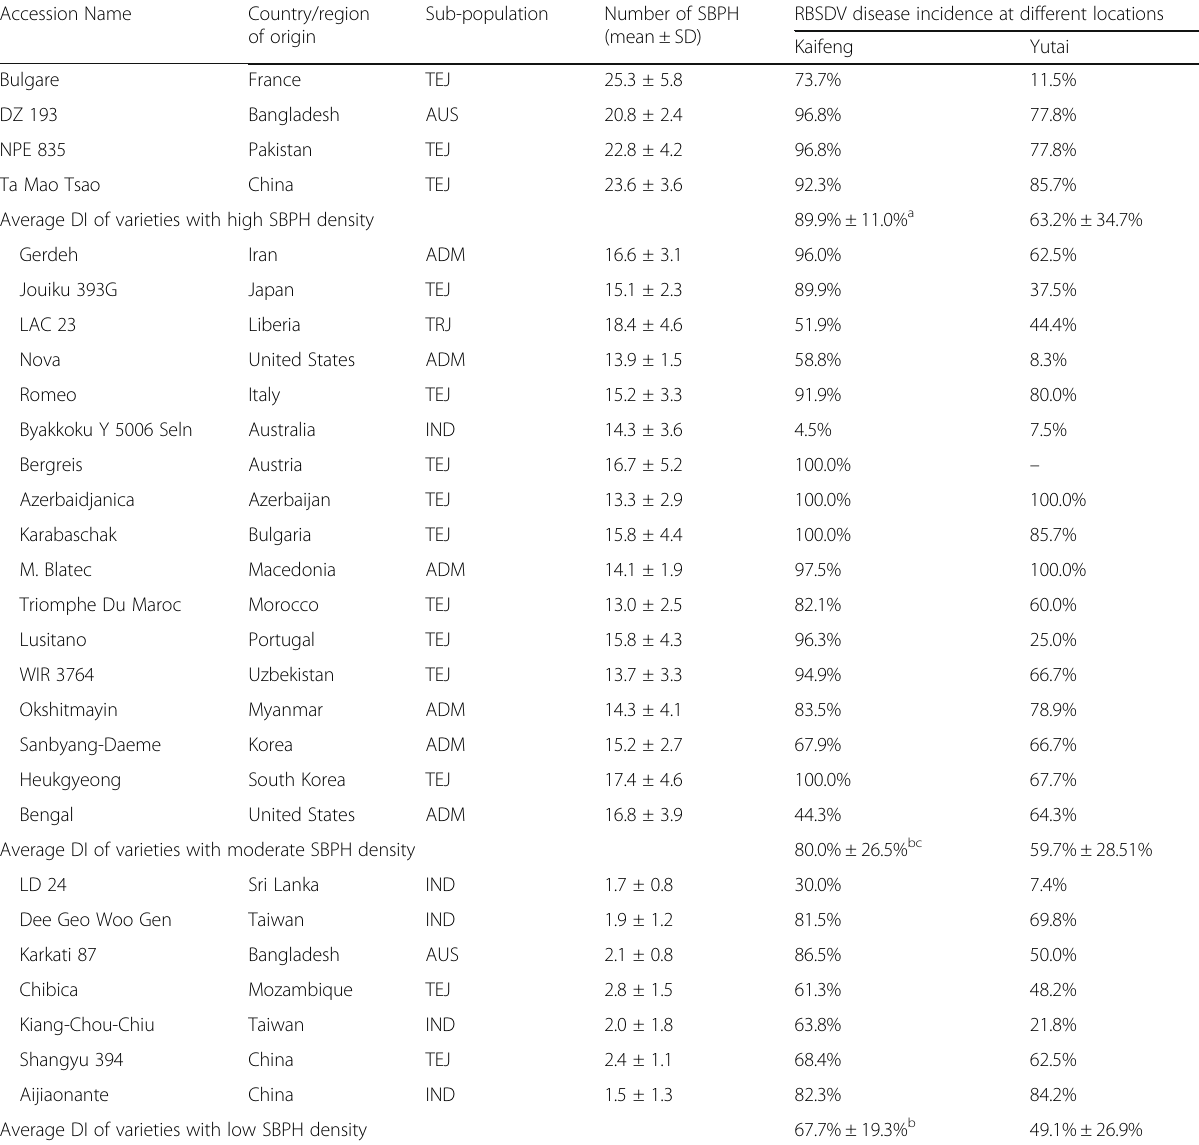
Table 1 Disease incidences of the RBSDV disease and the number of SBPH landing on the varieties Accession